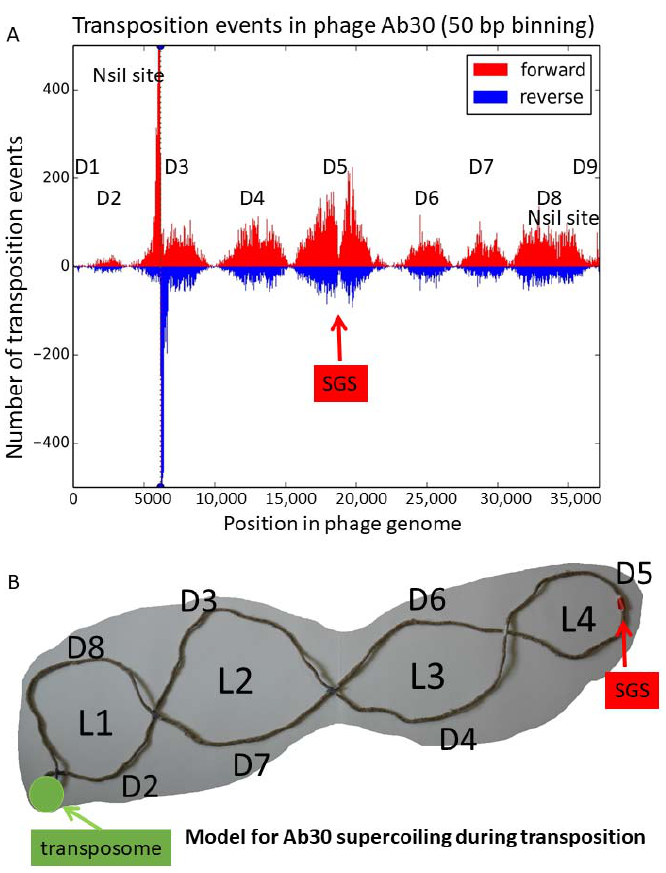
Figure 5. The discovery of a pattern of transposition events along the Ab30 genome. The position along the phage Ab30 genome of transposition events which occurred within the phage is plotted.